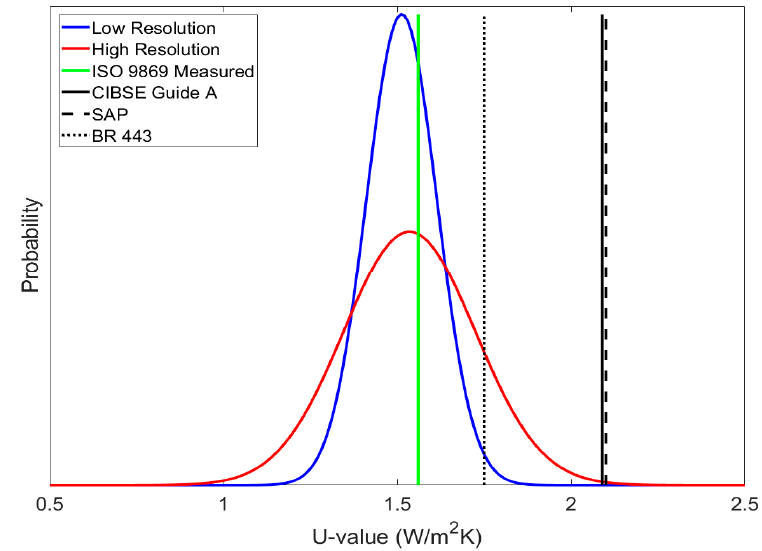
Figure 7. Normal distribution density of U-values from IRT for the living room external wall, compared to a point measurement and standardised values.